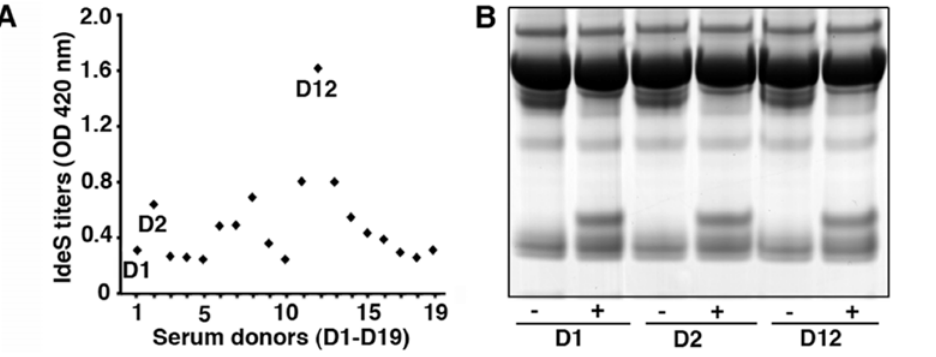
Figure 2. IgG antibodies against IdeS in human sera do not interfere with the enzymatic activity. (A) Antibody titers against IdeS in serum samples from nineteen healthy donors (D1–D19). (B) SDS-PAGE analysis of serum samples untreated ( 2 ) or preincubated with IdeS (20 m g/ml serum) for three hours at 37 u C ( + ).